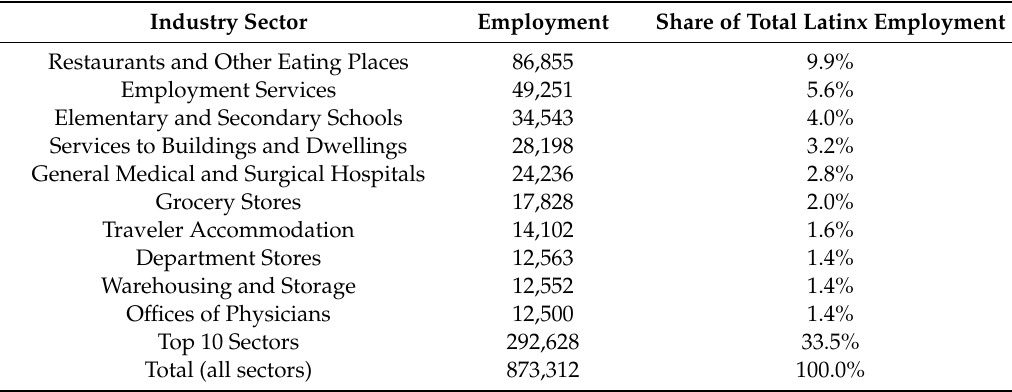
Table 1. Top 10 Industry Sectors by the Size of Latinx